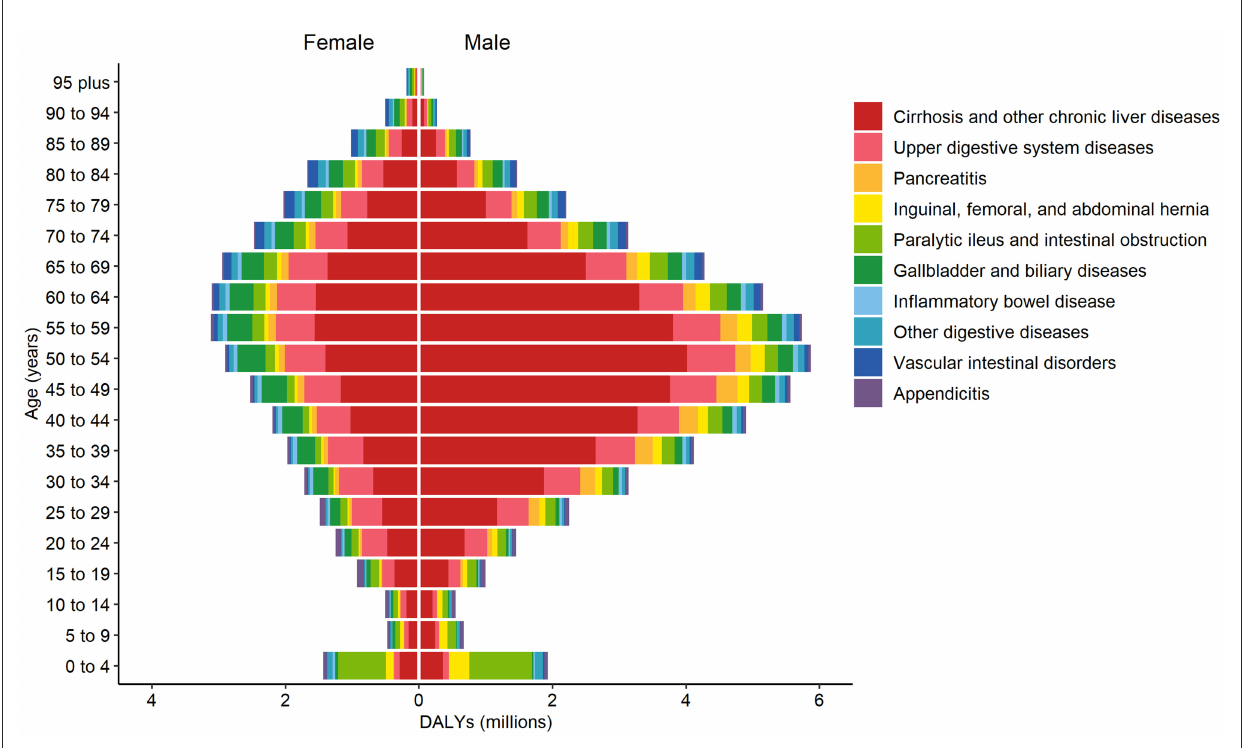
diseases were found in Iceland, Singapore, Switzerland,